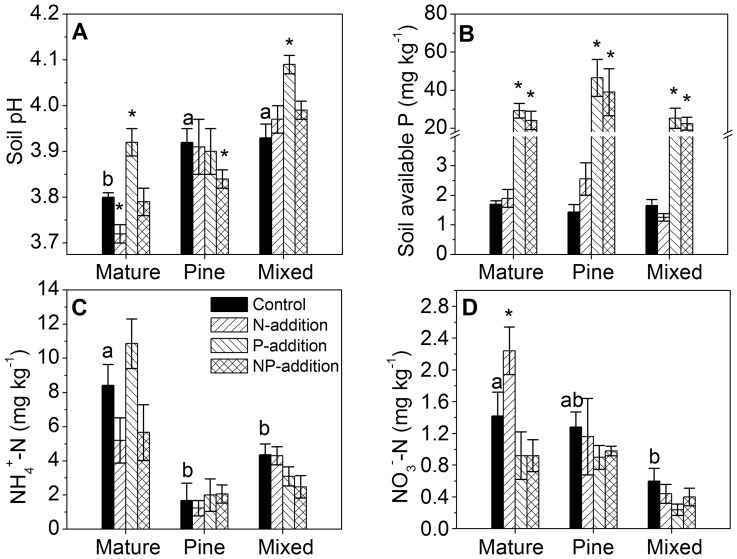
Soil pH, available P and N (NH4
+-N and NO3
−-N) after four years of nitrogen and phosphorus additions.Data from July 2011. Different letters indicate significant differences among forests (P<0.05). * indicates significant differences between each treatment and control (P<0.05). Error bars show SE (n = 5).